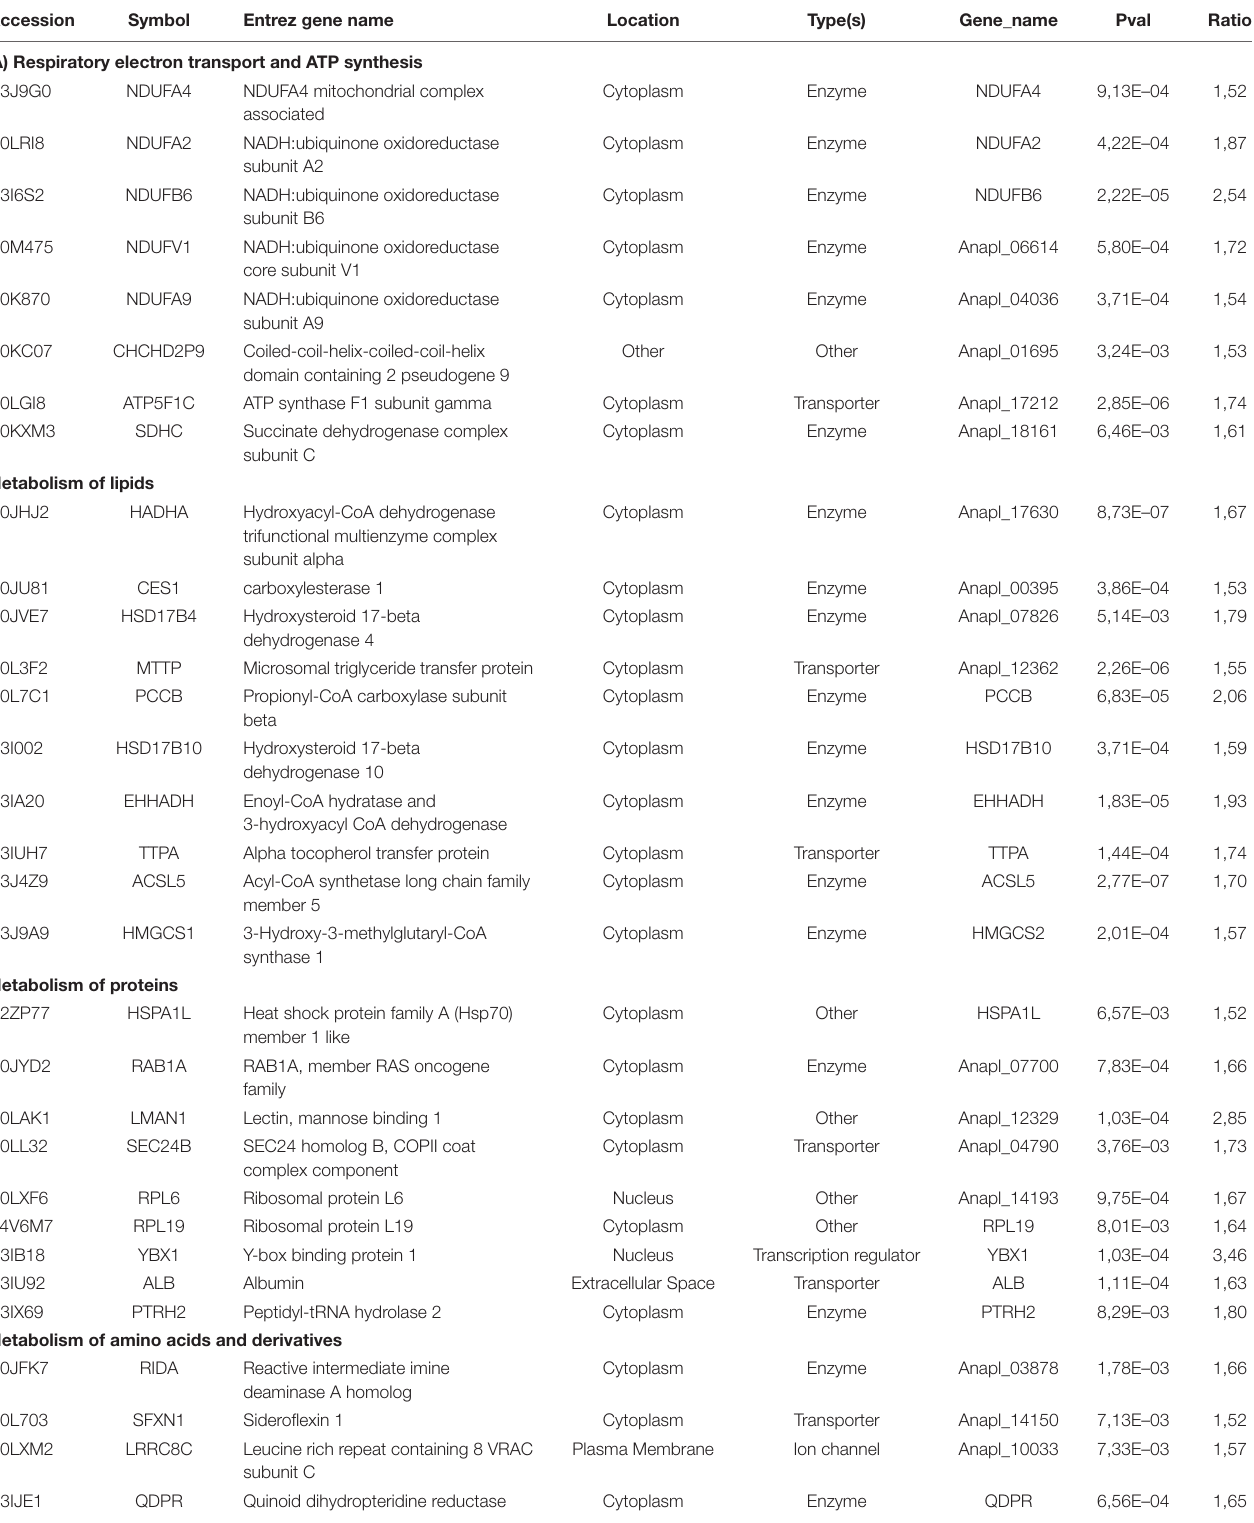
TABLE 1 | List of proteins after GO enrichment analyses. (A) Biological process associated to overexpressed proteins in low weight livers (LWL). Ratio = intensity LWL/intensity HWL. (B) Biological process associated to overexpressed proteins in high weight livers (HWL). Ratio = intensity HWL/intensity LWL. Accession